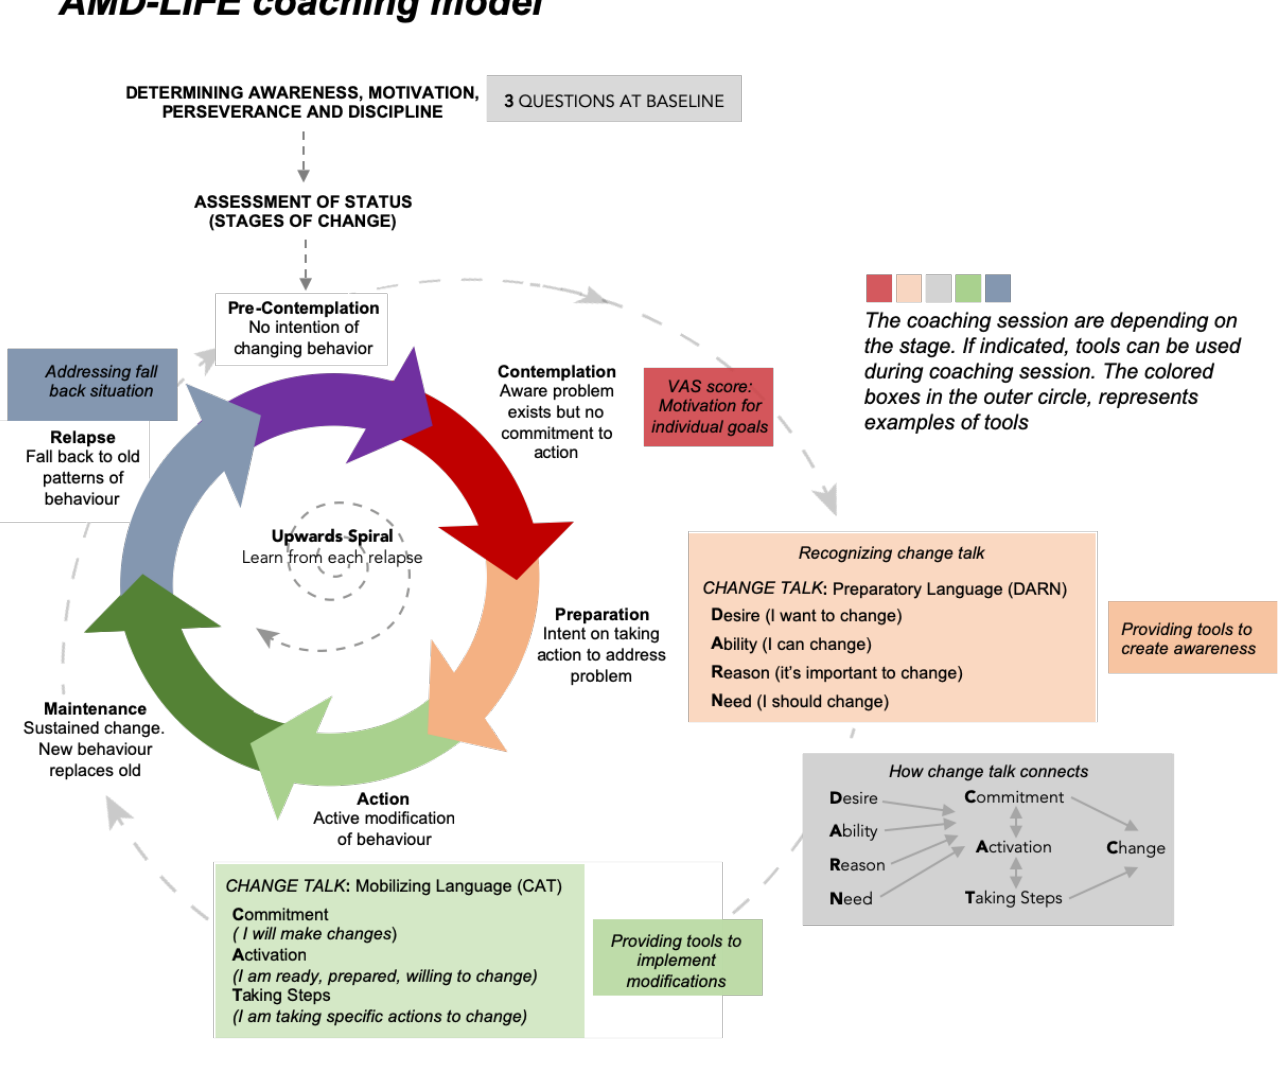
Figure 2. AMD-Life coaching model. The AMD-Life coaching model reflects an upwards spiral to learn from each relapse. Included in the model are: ‘the 3 questions’ at baseline to determine aware- ness, motivation, perseverance and discipline, and goal-setting; a model for Behavioral Change Technique (BCT), the transtheoretical model of change (determining of ambivalence/assessment of status), adapted with permission from Prochaska and DiClemente [39,41]; and a model for motiva- tional interviewing (MI), increasing/recognizing of ‘change talk’ through DARN -CAT, adapted